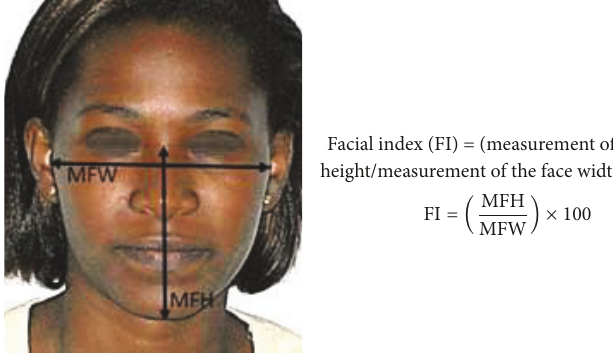
Figure 2: Face index determination